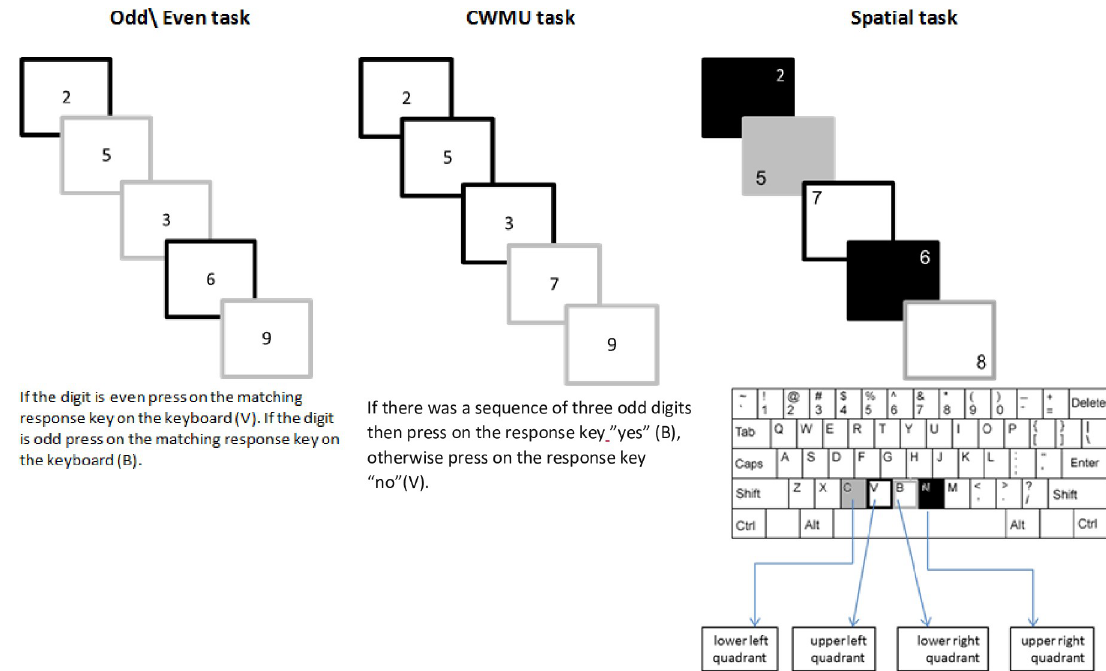
Fig 1. Procedure of the secondary task presentation employed in Experiments 1 and 2. CWMU = continuous working memory updating.